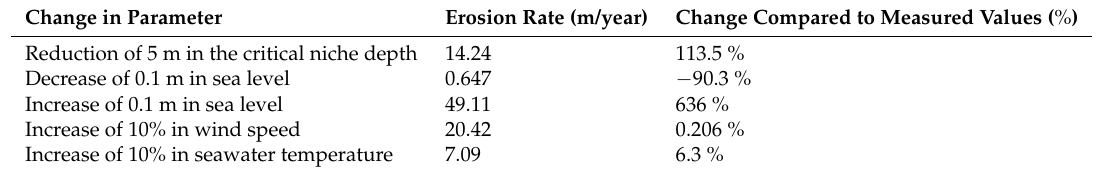
Table 6. Sensitivity of the erosion rate to variations in model parameters compared to the base case of 2012–2013. Change in